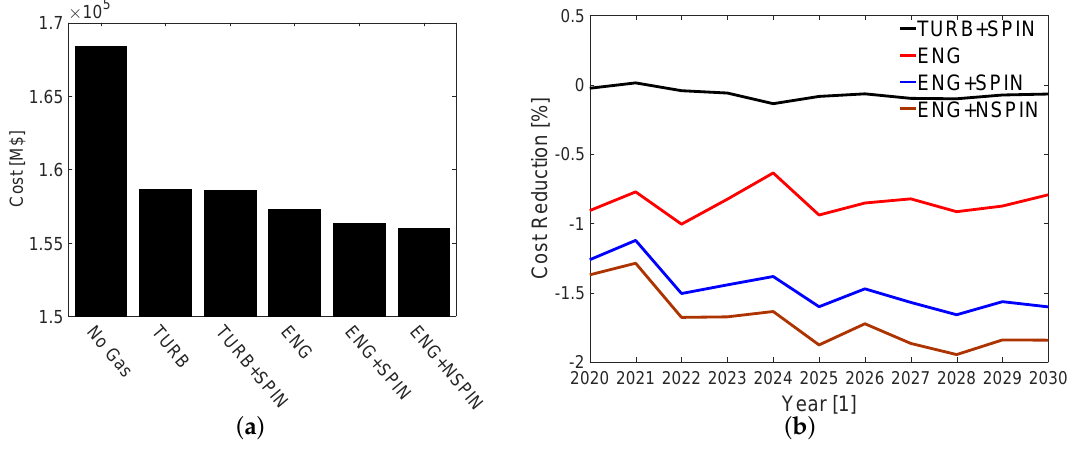
Figure 5. Total operation cost of the system for each case ( a ) and the yearly reductions compared to the TURB case ( b